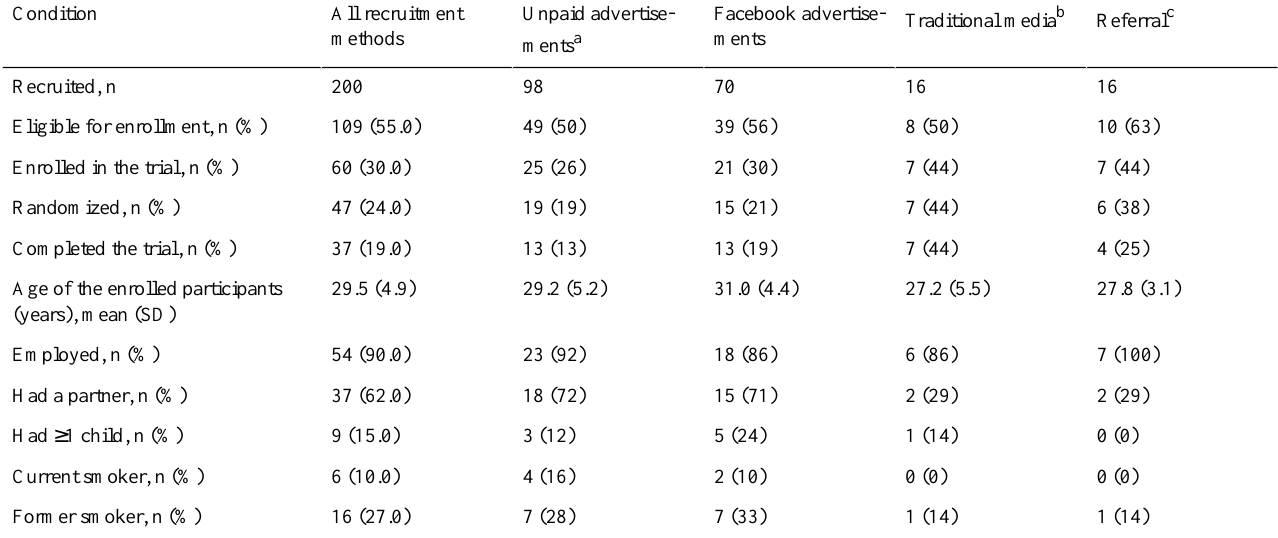
Table 2. Recruitment and completion of an exercise trial for women with polycystic ovary syndrome in Calgary (Alberta, Canada) in 2017-2020